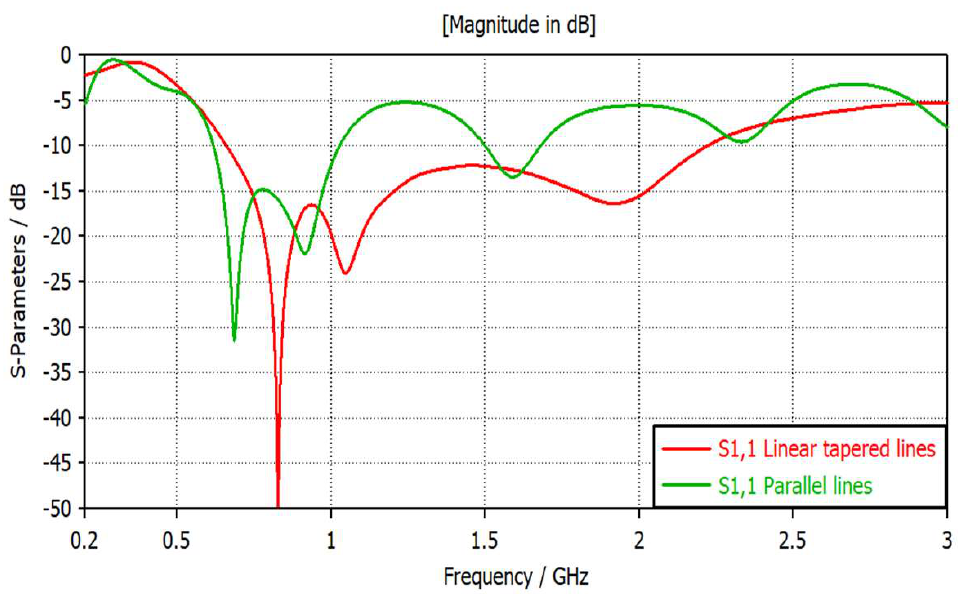
Figure 5. Return losses vs. frequency for both straight and tapered feeding lines.